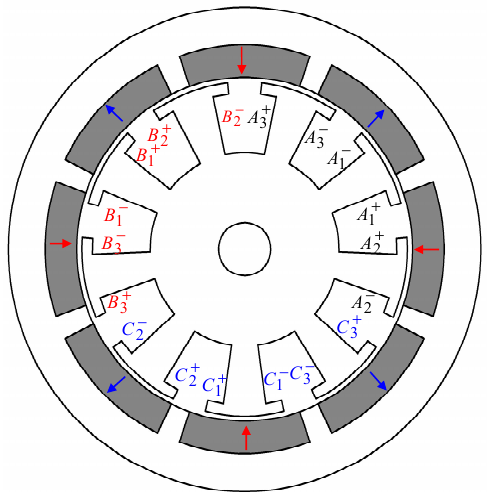
Figure 5. The machine topology and winding configuration.